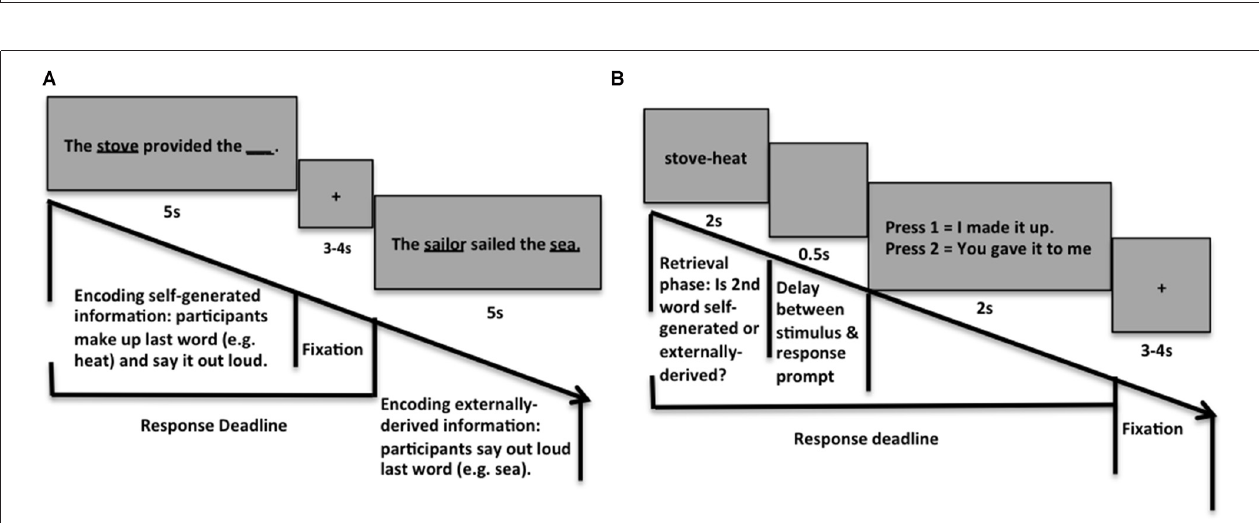
FIGURE 2 | Reality Monitoring Task Design. (A) During encoding, participants were given sentences in which the final word was either left blank for participants to generate themselves (e.g., The stove provided the __) or was externally-derived as it was provided by the experimenter (e.g., The sailor sailed the sea ). (B) During retrieval, participants were randomly presented with the noun pairs from the sentences (e.g., stove-heat ), and had to identify with a button-press whether the second word was previously self-generated or